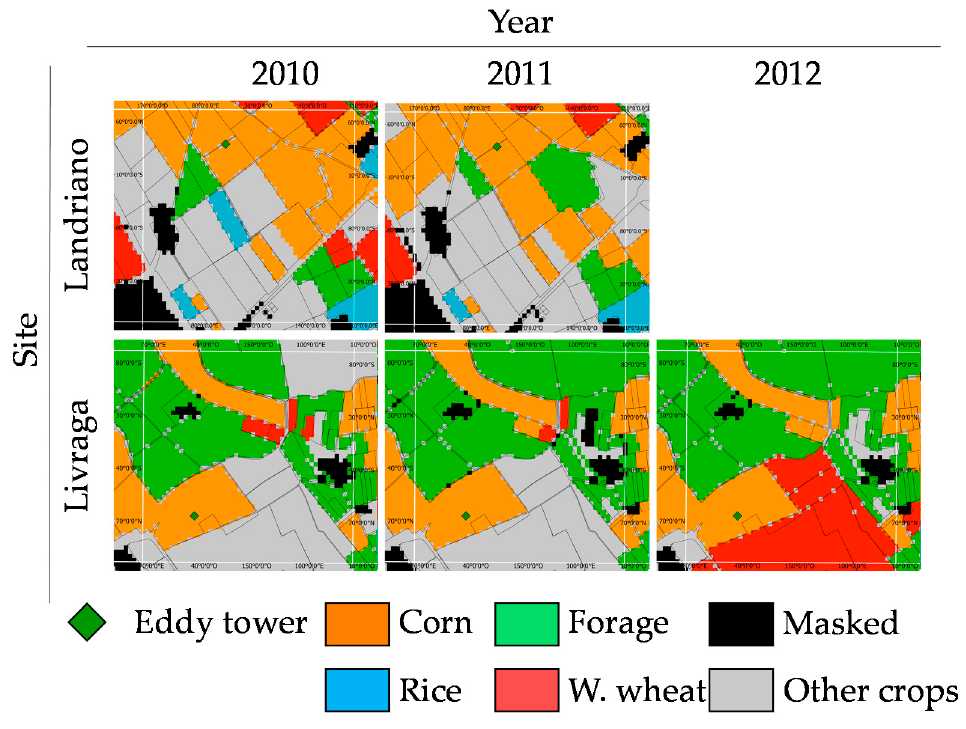
Figure A1. Zoom of the CUUA maps on the 1 km pixels (white squares) in correspondence of the eddy towers for the analyzed years.